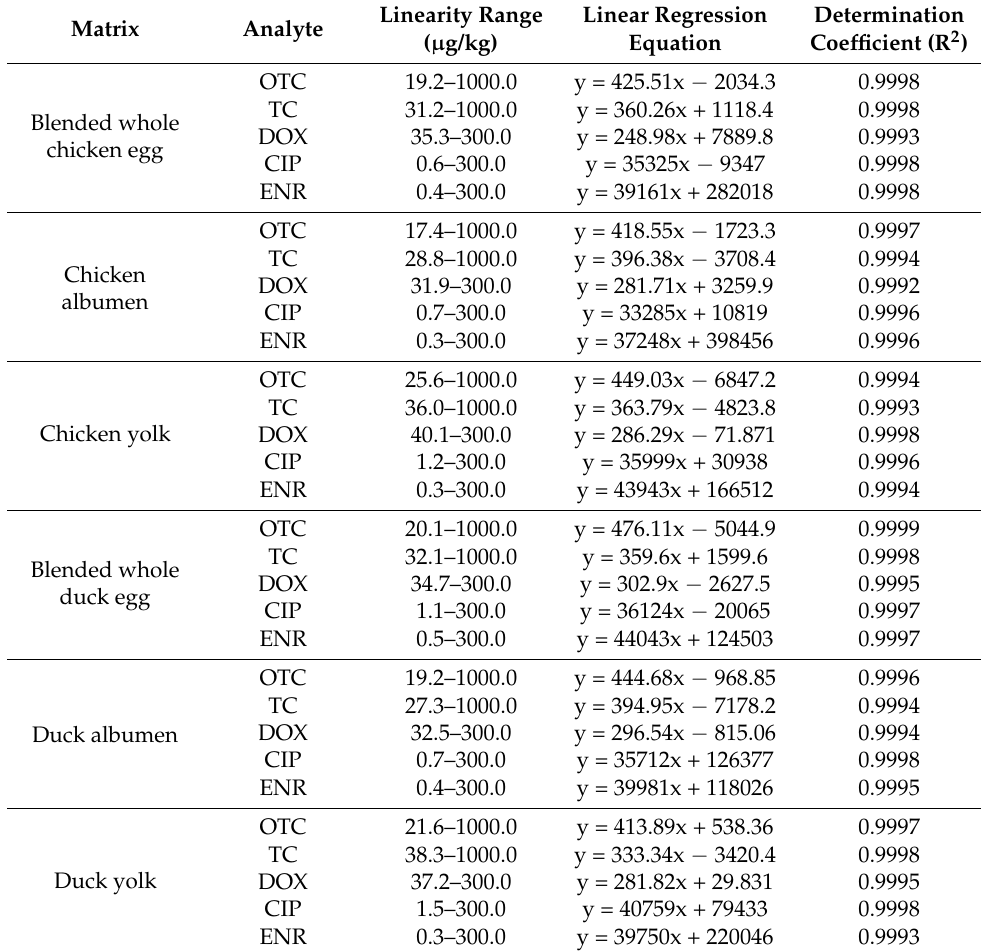
Table 1. Linearity ranges, linear regression equations and determination coefficients for determina- tions of OTC, TC, DOX, CIP and ENR in poultry